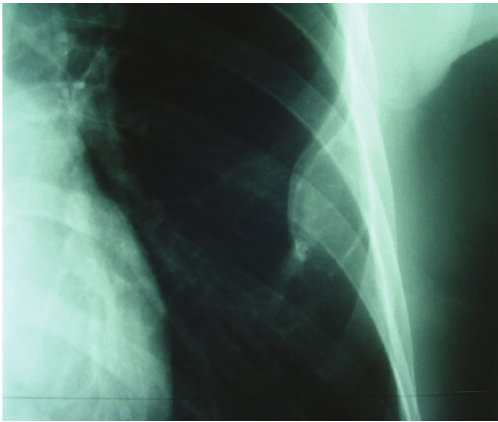
Figure 1: Chest radiography : Ovo¨ıd opacity of the lateral arch of the 6th left rib.